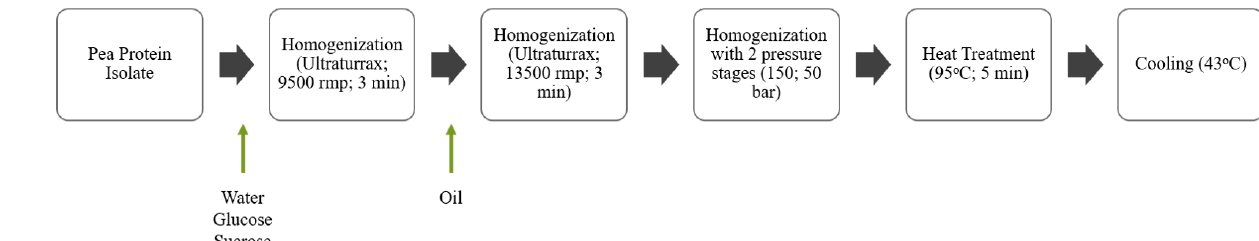
Figure 1. Production process of a pea protein isolate (PPI) matrix for plant-based